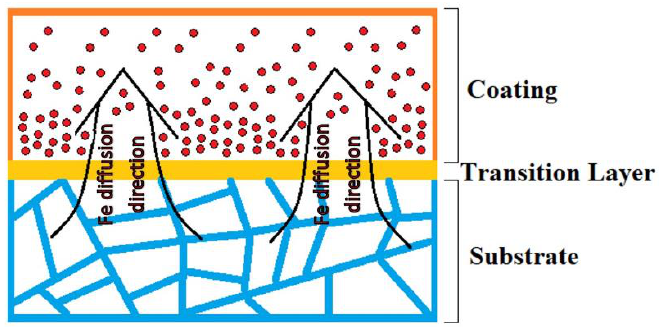
Figure 4. Scheme of coating saturation with Fe ions.